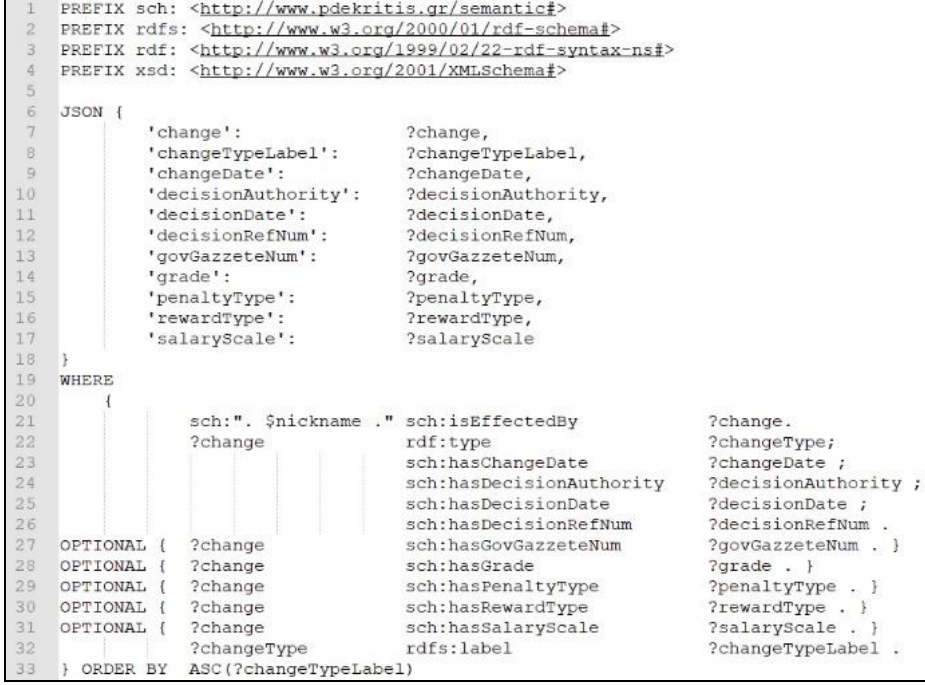
Figure 10. SPARQL query for retrieving Employee’s changes.